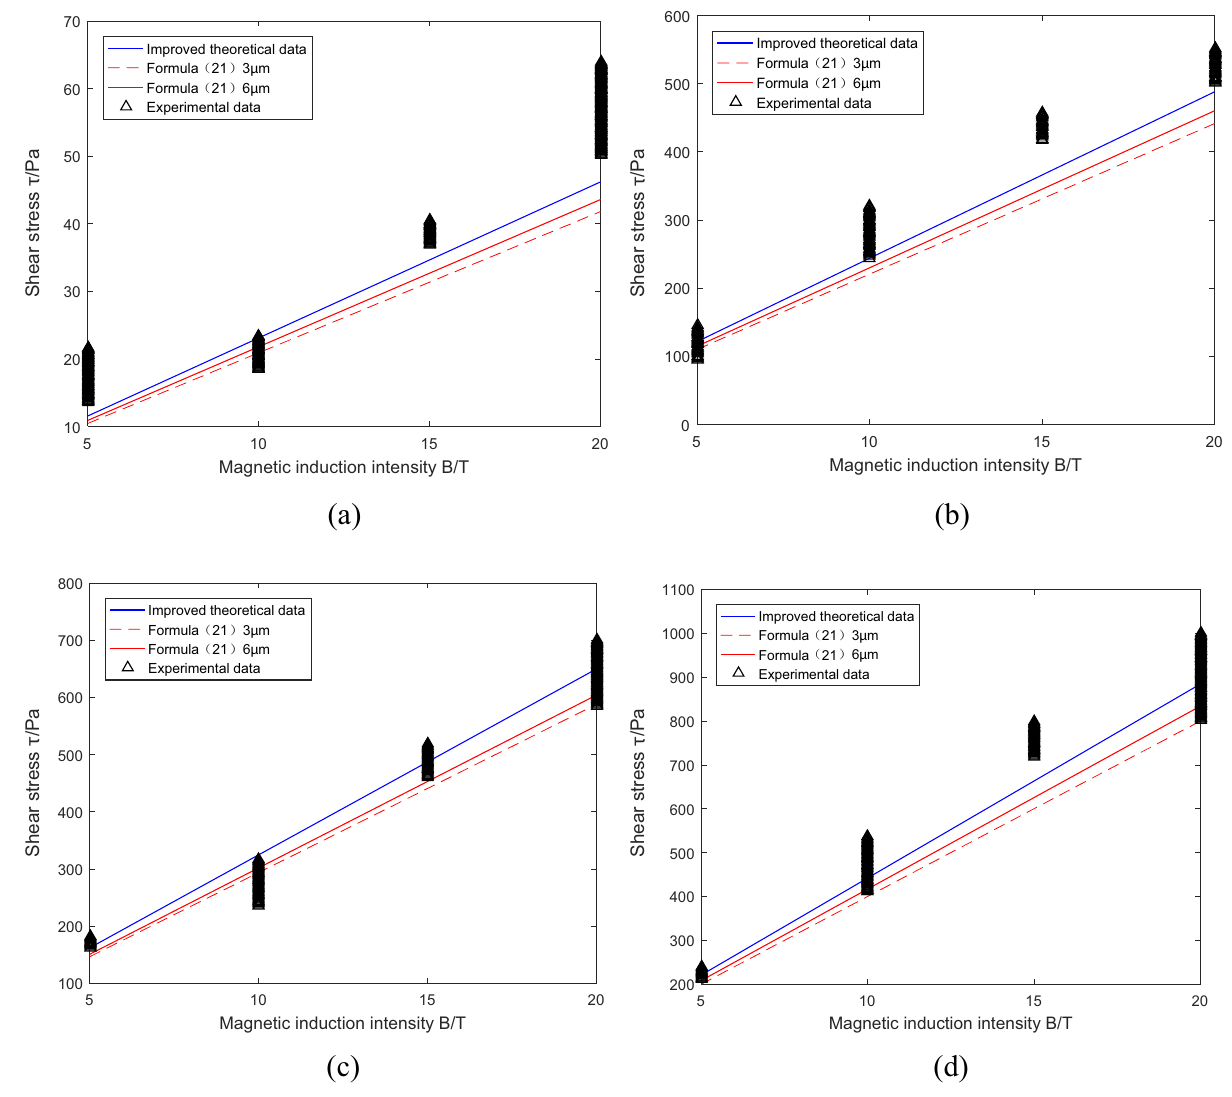
Figure 5: Changes of particle volume fraction and shear stress under di ff erent magnetic induction intensities graph: ( a ) magnetic induction intensities is 0.08 T; ( b ) magnetic induction intensities is 0.26 T; ( c ) magnetic induction intensities is 0.3 T; and ( d ) magnetic induction intensities is 0.35